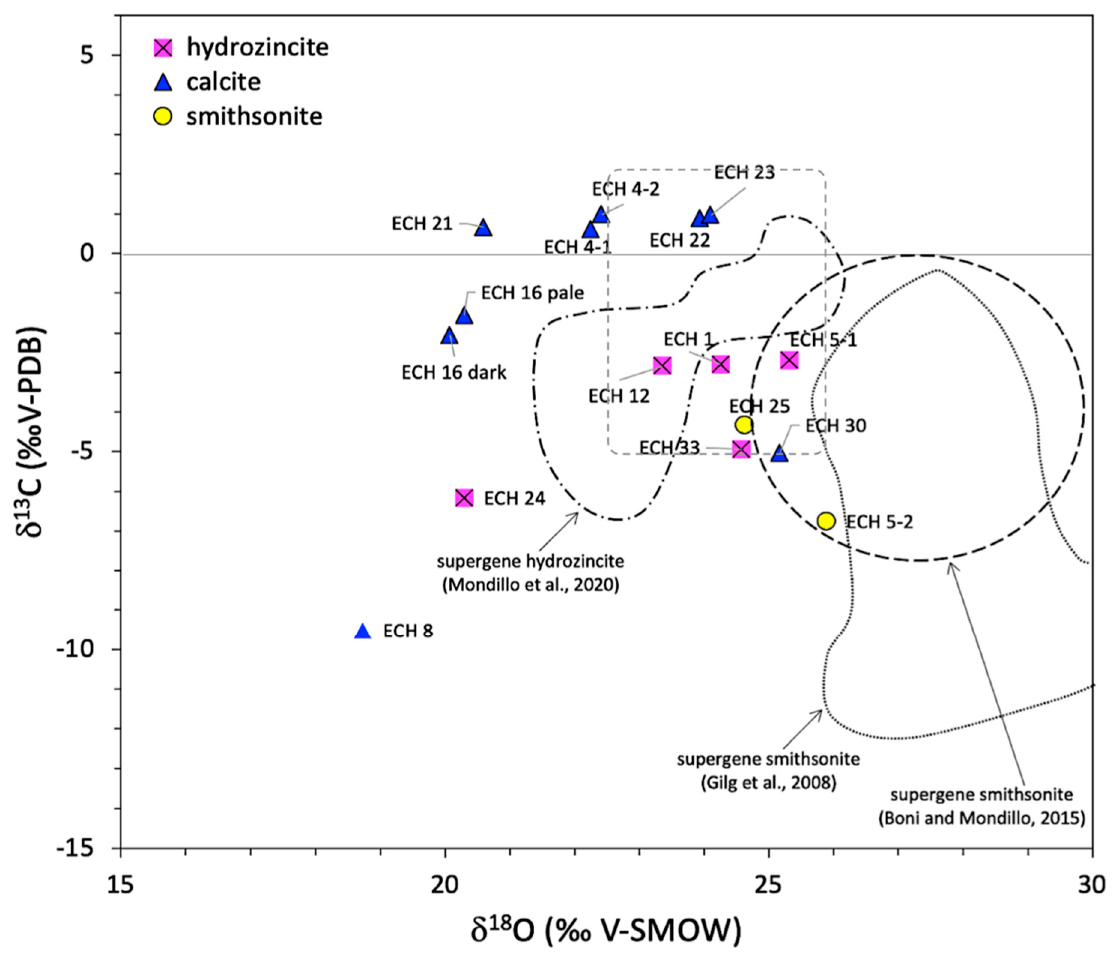
Figure 9. Carbon and oxygen isotope composition of carbonates from the Bou Caïd orefield. The fields from literature are from [23] (dotted line), [29] (dash-dotted line), [30] (dashed line), and [28] (grey dashed line).